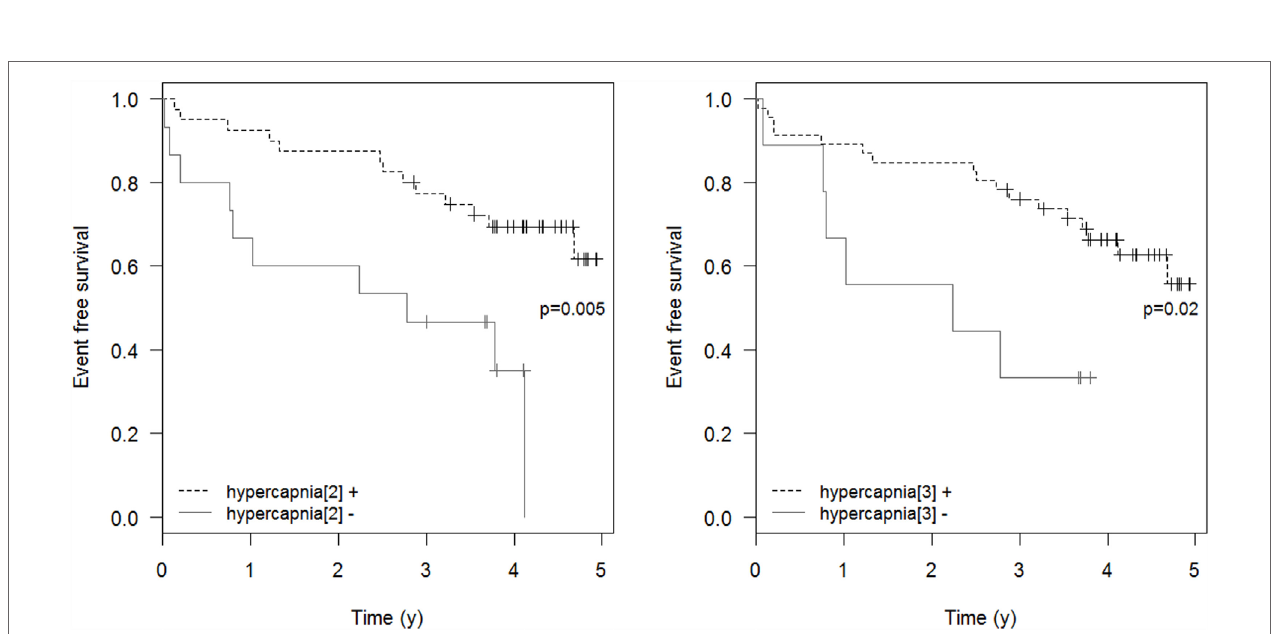
FigUre 2 | cumulative incidence of respiratory events requiring icU admission . “hypercapnia[2]”: TcCO 2 > 49 mmHg during ≥ 10% of the total recording time; “hypercapnia[3]”: peak TcCO 2 > 55